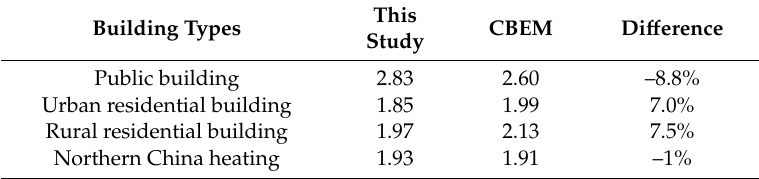
Table 3. Data comparison of energy consumption of three building types, in 100 million